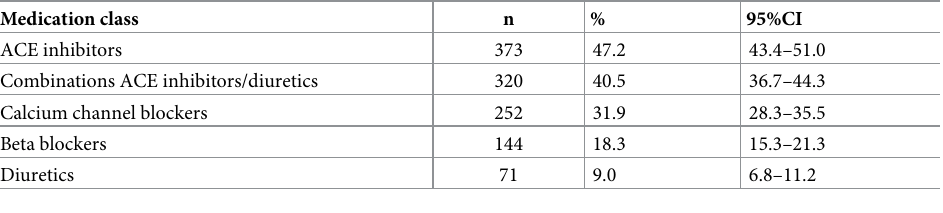
Table 5. Antihypertensive